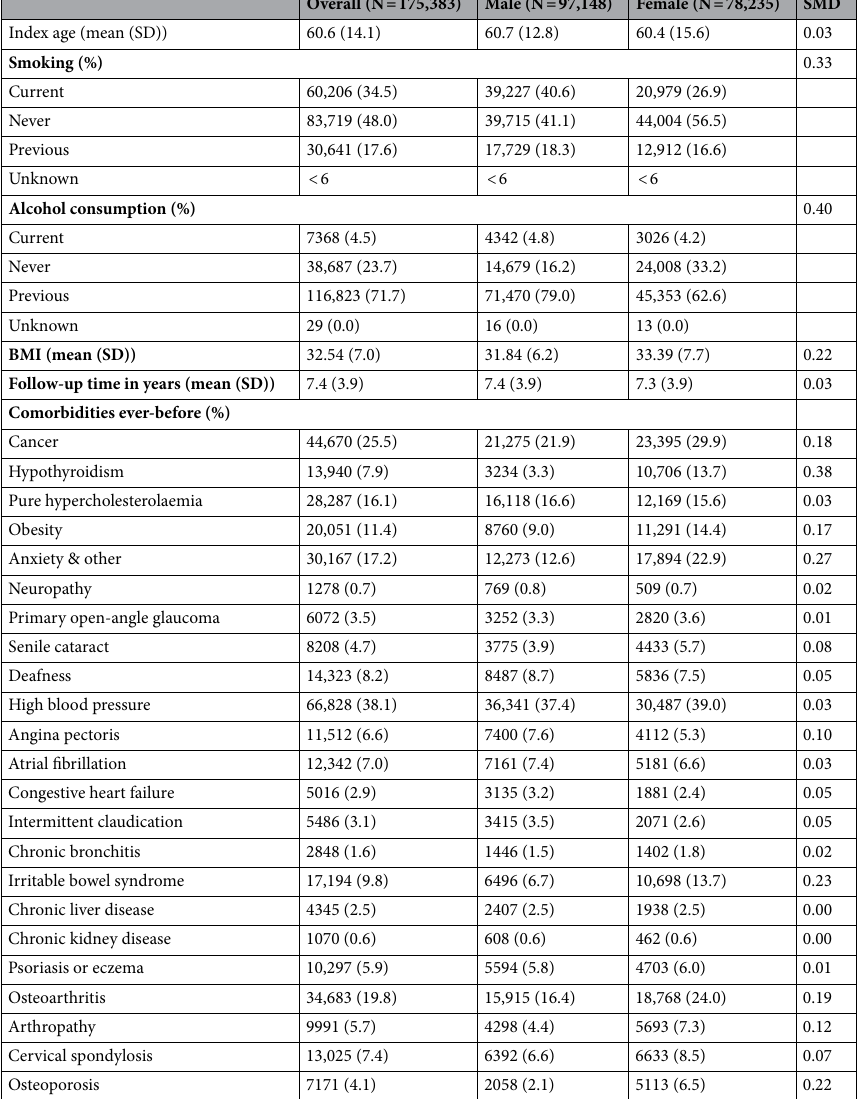
Table 1. Demographic characteristics of 175,383 T2DM patients at index date (first NIAD prescription). SMD, Standardized mean difference. All identified comorbidities were identified via read codes, as recorded anytime on or before the index date, defined as the first prescribed non-insulin antidiabetic drug